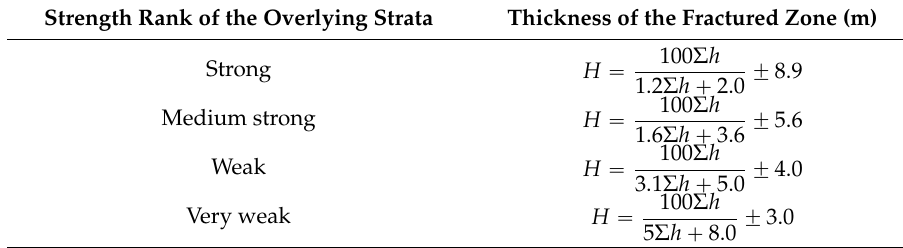
Table 2. Empirical expressions for the delimitation of the thickness of the fractured zone ( H ) used in China